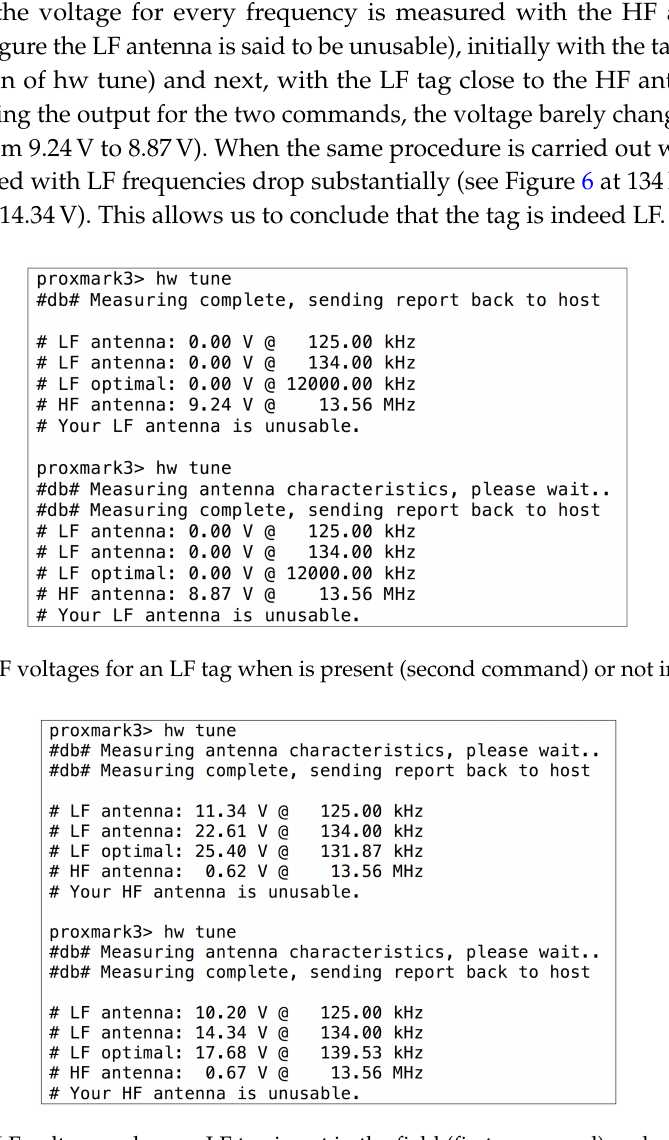
Figure 6. LF voltages when an LF tag is not in the field (first command) and when it